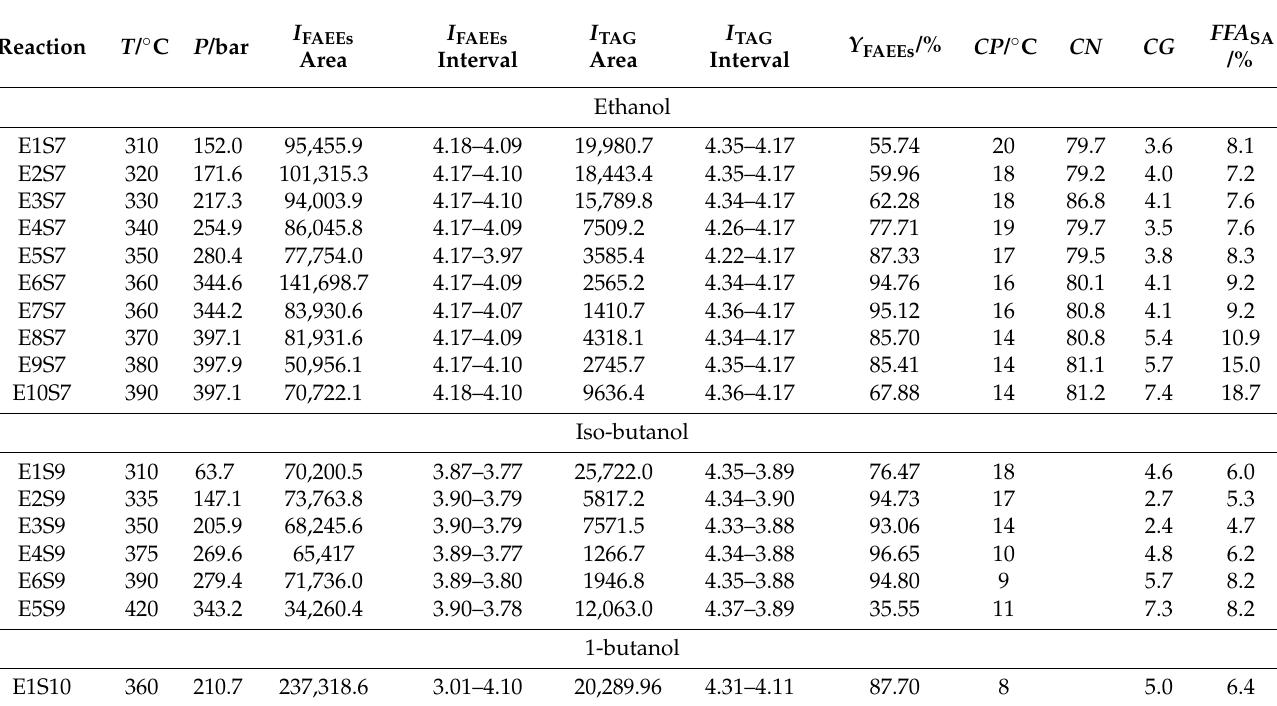
Table 2. Properties for each transesterification at 45:1 of molar ratio for